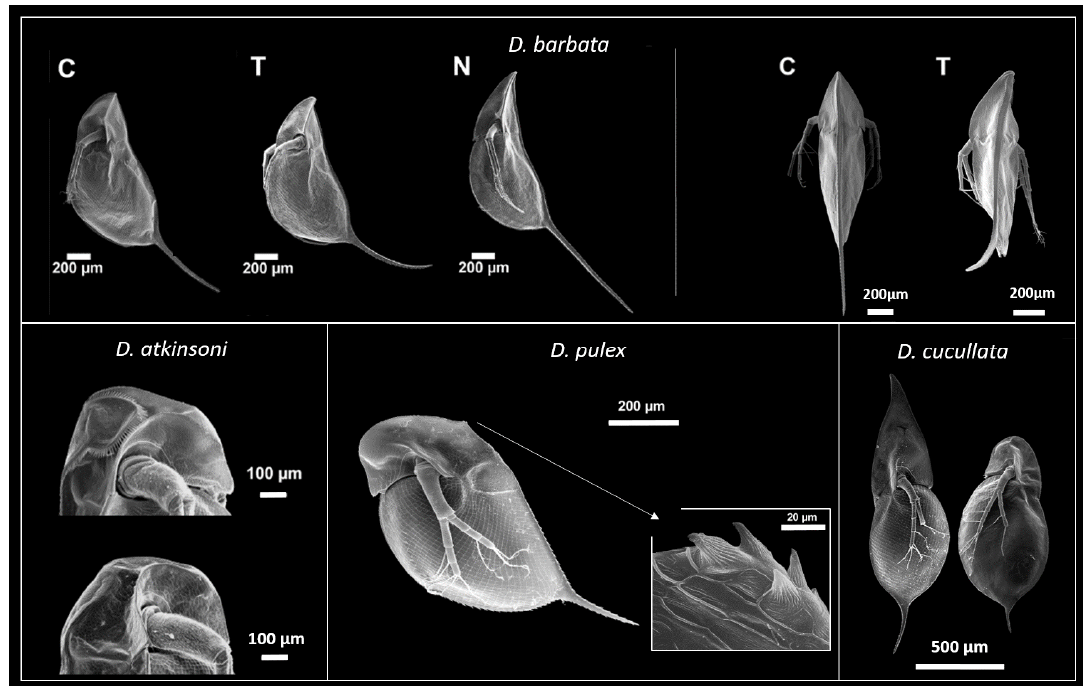
Figure 1. Inducible morphological defences in Daphnia . Top row: D. barbata expressing morphological defences in tail spine, helmet, and bilateral symmetry under exposure to Triops cancriformis (T) and Notonecta glauca (N) compared to the control (C) [28,158]. Bottom row: D. atkinsoni expressing a crown of thorns against T. cancriformis (top) compared to the control (bottom) [156]. D. pulex with neckteeth as defence against Chaoborus ([160], www.schweizerbart.de/journals/fal). D. cucullata with Chaoborus -induced helmet and tail spine (left) compared to the control (right).